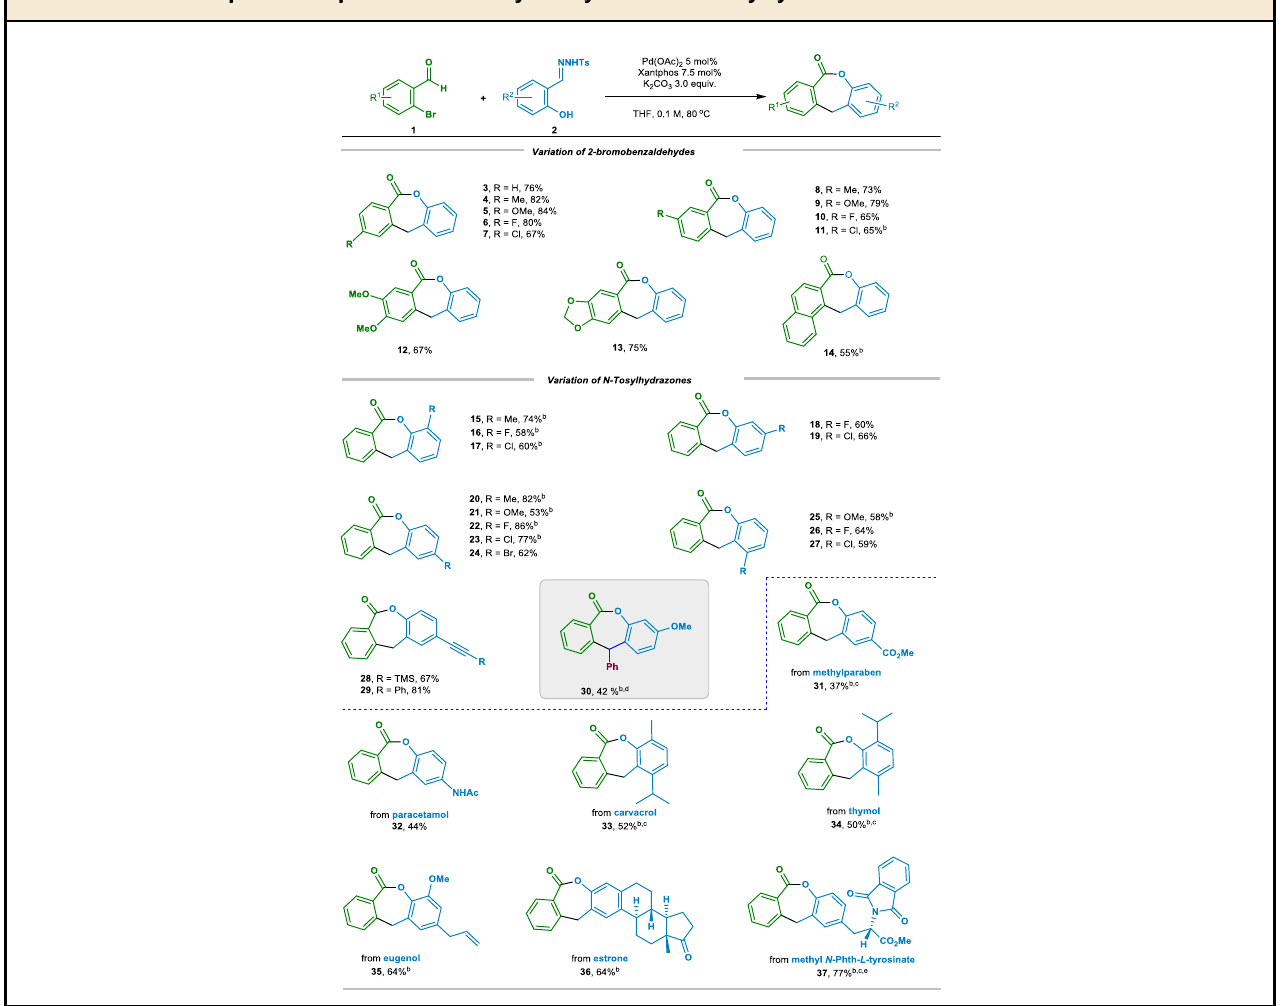
Table 2 Substrate scope with respect to o -bromoarylaldehydes 1 and N -tosylhydrazones 2 a